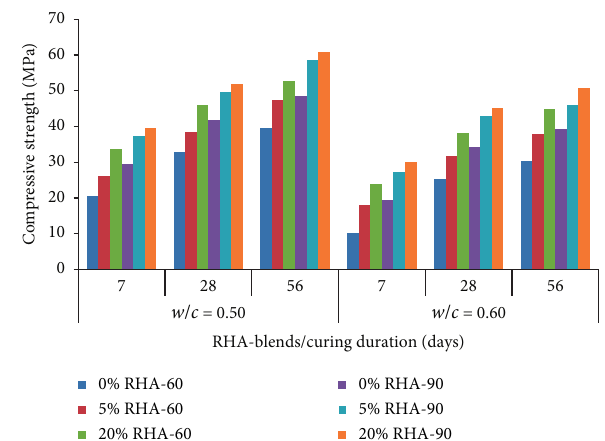
Figure 7: Compressive strength development at different curing durations verses RHA-blends type.